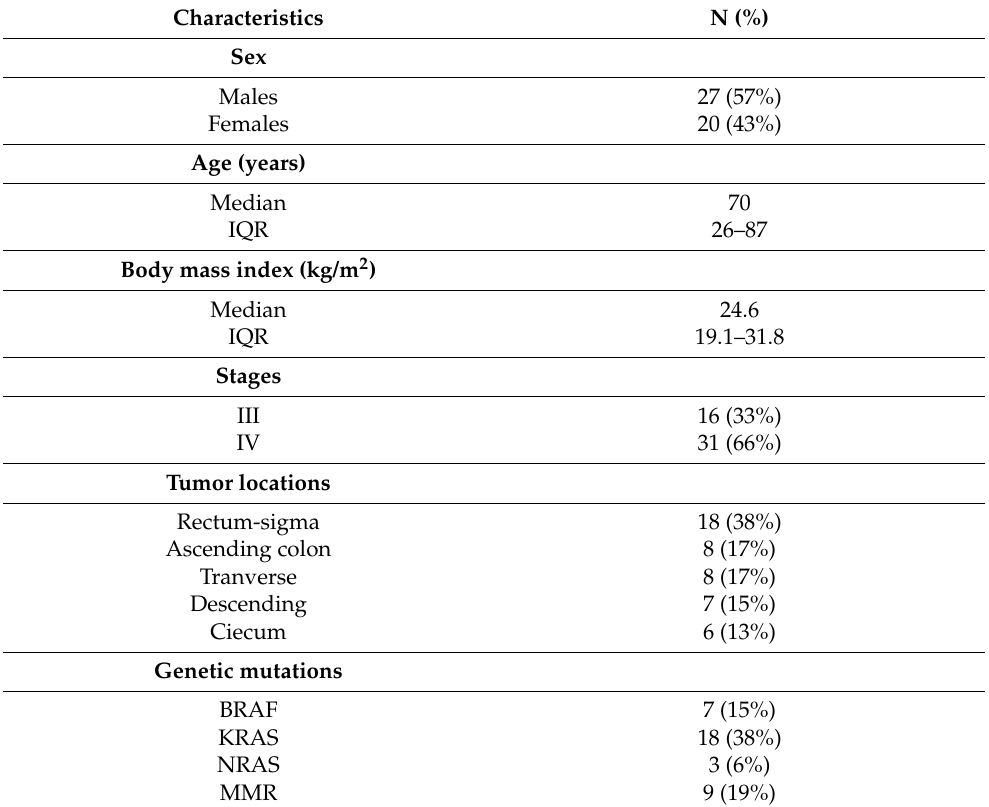
Table 1. Demographic and clinical–pathological characteristics of the studied